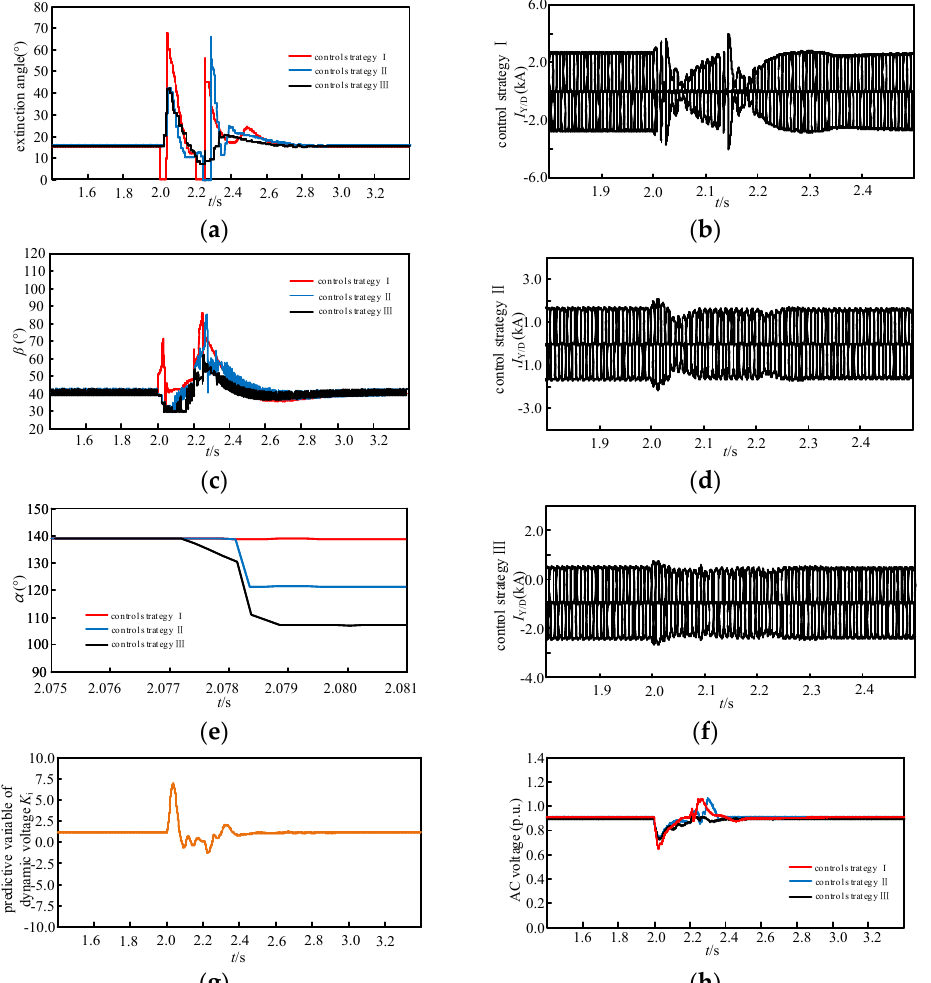
Figure 13. Waveforms of three-phase short-circuit grounding fault under different strategies. ( a ) Extinction angle γ under three strategies. ( b ) Current at valve side of converter transformer under strategy Ⅰ . ( c ) Trigger advance angle β under three strategies. ( d ) Current at valve side of converter transformer under strategy Ⅱ . ( e ) Trigger delay angle α under three strategies. ( f ) Current at valve side of converter transformer under strategy Ⅲ . ( g ) Predictive variable of dynamic voltage K i . ( h ) AC voltage at inverter side.